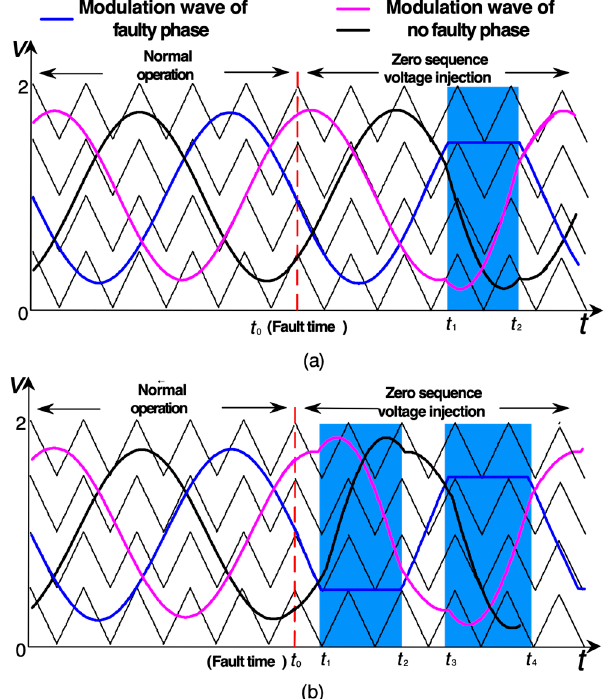
Figure 3. Diagram of zero sequence voltage injection modulation: ( a ) Schematic diagram of fault modulation wave of upper arm; ( b ) Schematic diagram of fault modulation wave of upper arm and lower arm.